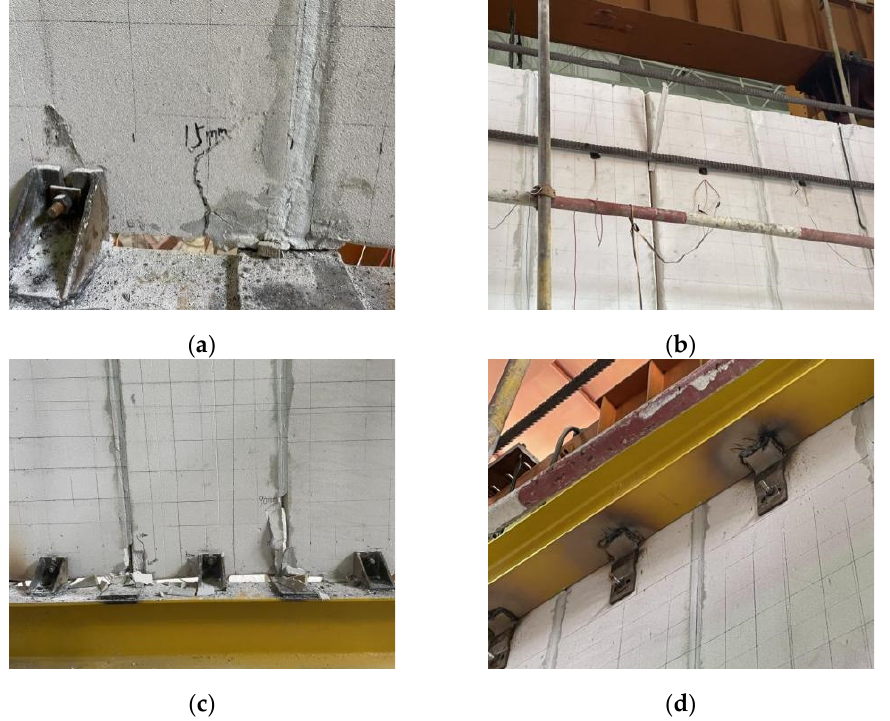
Figure 13. Crack pattern of specimen FW-2: ( a ) crack in the bottom of the plane; ( b ) vertical cracks are produced; ( c ) ALC panel corner shattering; ( d ) slippage of connectors was obvious.